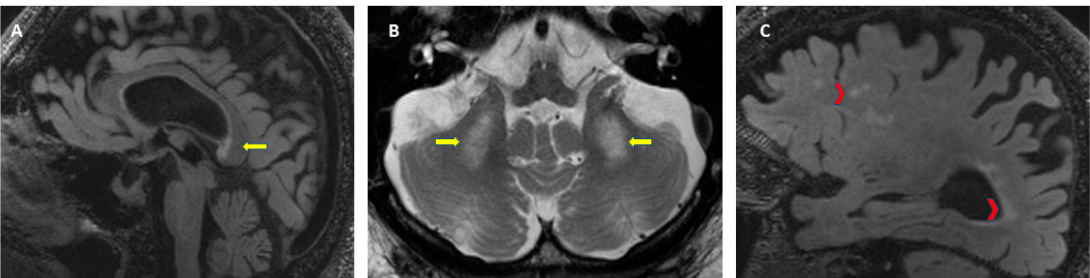
Figure 4. Neuroradiological criteria for the diagnosis of FXTAS. ( A ) T2-FLAIR: white matter lesions in the splenium of the corpus callosum, ( B ) T2-TSE: symmetrical white matter lesions in the middle cerebellar peduncles (MCP sign), ( C ) T2-FLAIR: cerebral white matter lesions and brain atrophy.